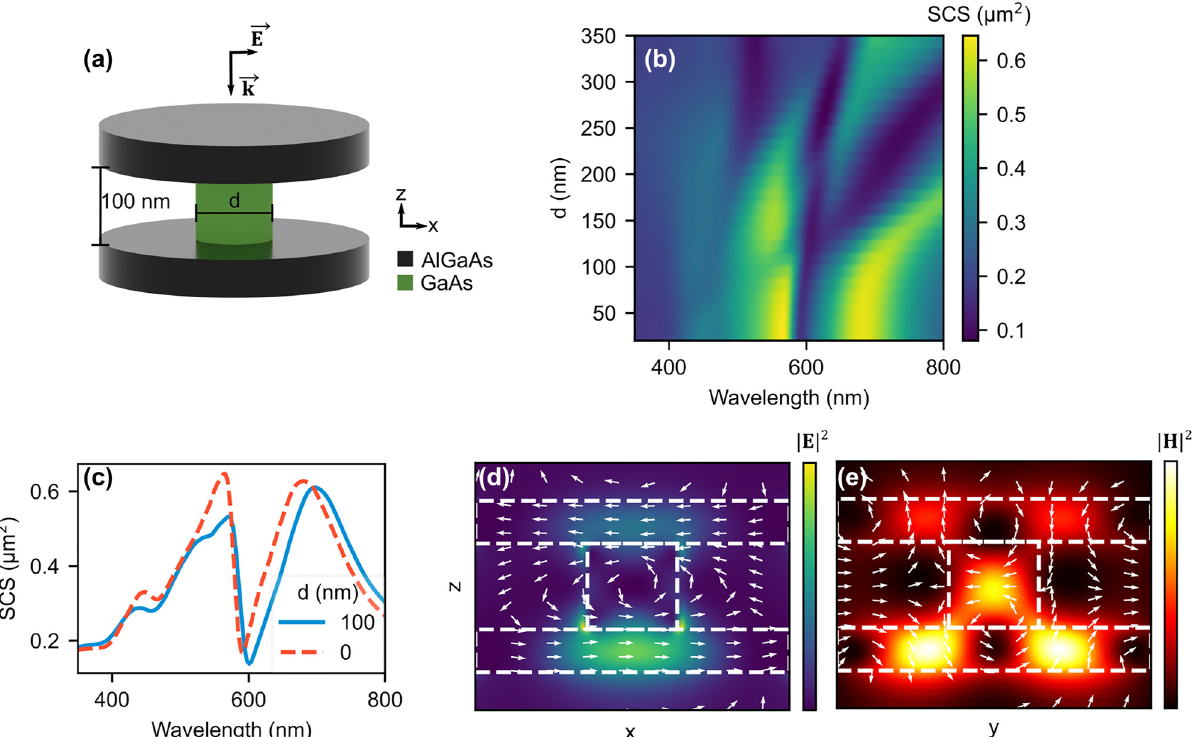
Figure 3: Influence of GaAs stem diameter on the scattering of two AlGaAs disks in air. (a) Schematic of two vertically stacked AlGaAs resonators connected with a GaAs stem with diameter ‘ d ’. The gap is kept at 100 nm. ⃗ E and the incoming radiation, respectively. (b) Effect on the SCS as d is varied from 20 to 350 nm. (c) The total SCS of a two disk system connected via a 100 nm diameter GaAs stem ( d = 100 nm), compared to the stem less system ( d = 0). The magnitude squared of the electric (d) and magnetic (e) fields in the XZ plane at y = 0. The white arrows indicate respective field